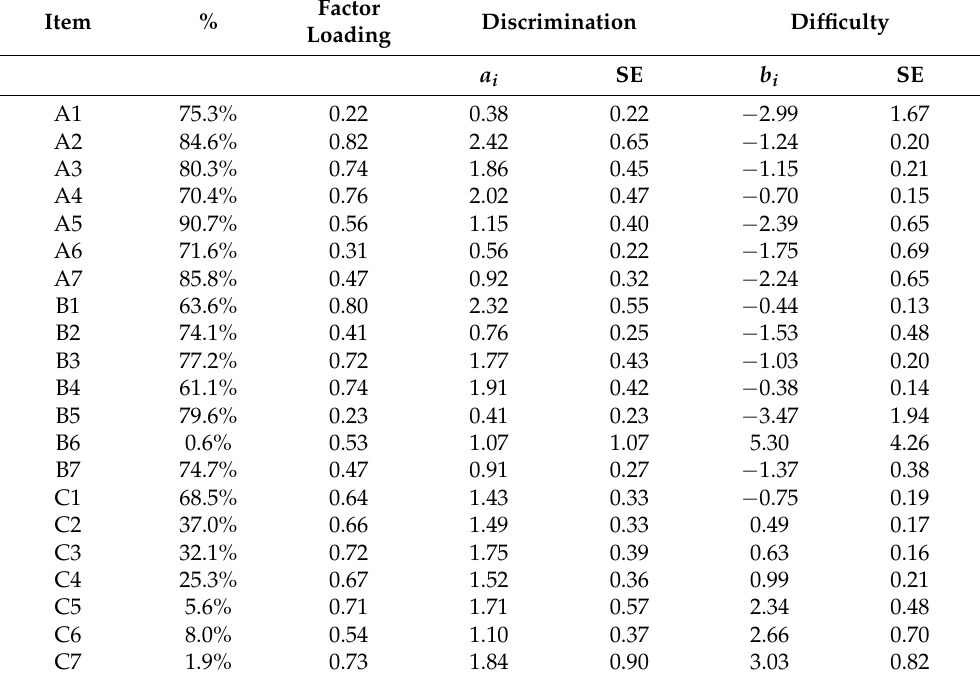
Table 3. The percentage success rate for the resolution of the tasks on the fractions test. Factor Item % Discrimination Difficulty Loading a i SE b